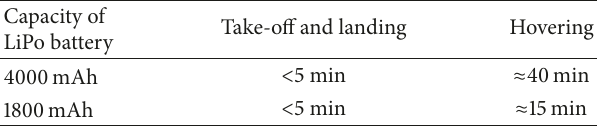
Table 4: Endurance for the two LiPo batteries